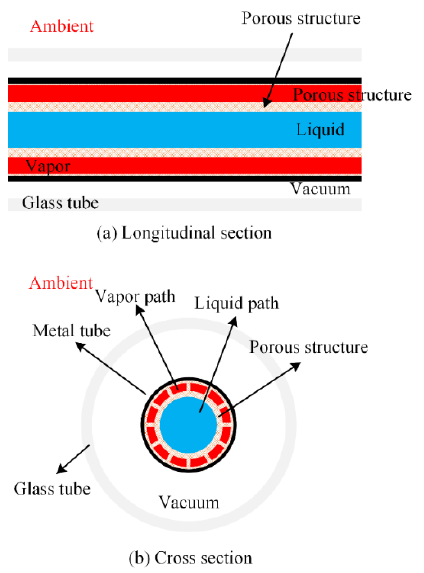
Figure 1. Absorber tube with artery porous structure: ( a ) Longitudinal side; ( b )